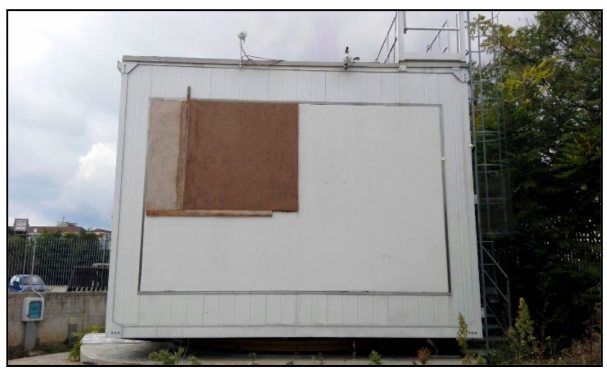
Figure 2. Hemp-lime mortar (mixture 1) applied on Matrix test room.